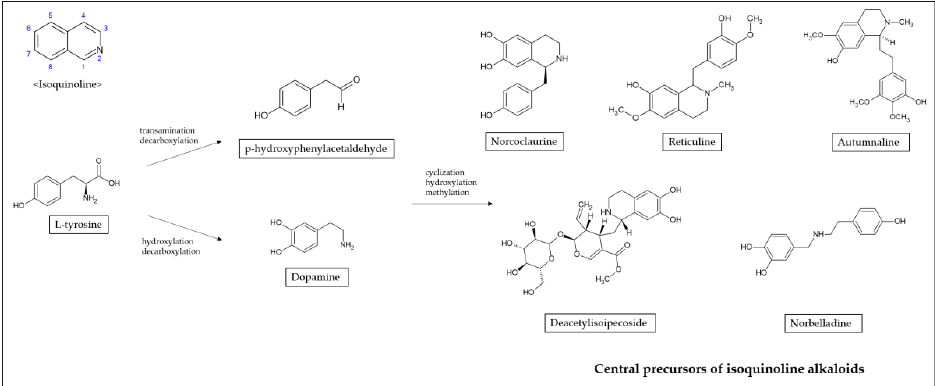
Figure 1. Synthesis of isoquinoline alkaloids.